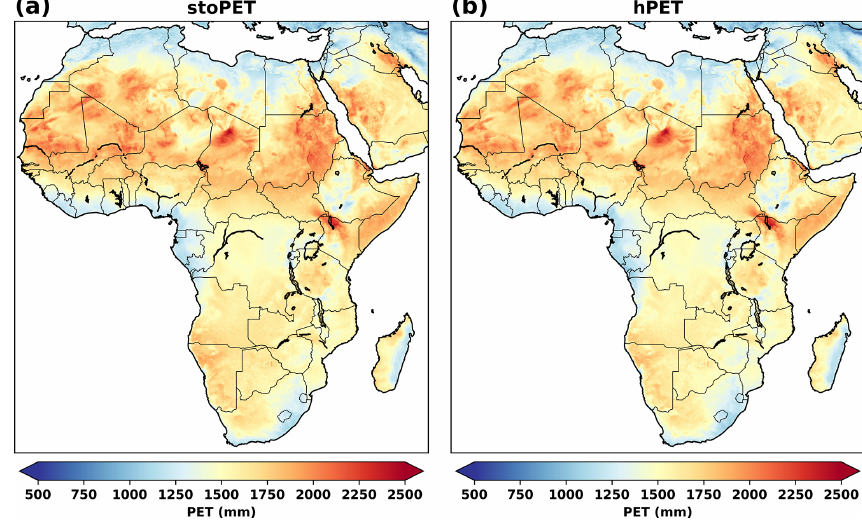
Figure 5. Average annual PET for 5 randomly selected years. (a) stoPET. (b) hPET with nighttime PET removed for